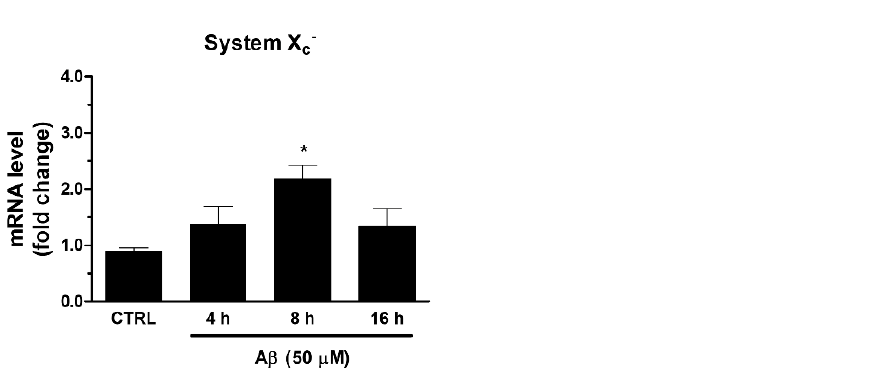
localization of System X c− in U373 cells treated with Aβ 25-35 (50 μM) for 24 h. Figure 5 shows